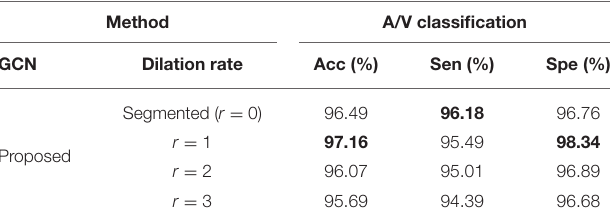
TABLE 4 | Graph edge arrangement analysis using the AV-DRIVE dataset. TABLE 5 | Comparison of different graph neural network (GNN) models using the AV-DRIVE dataset.